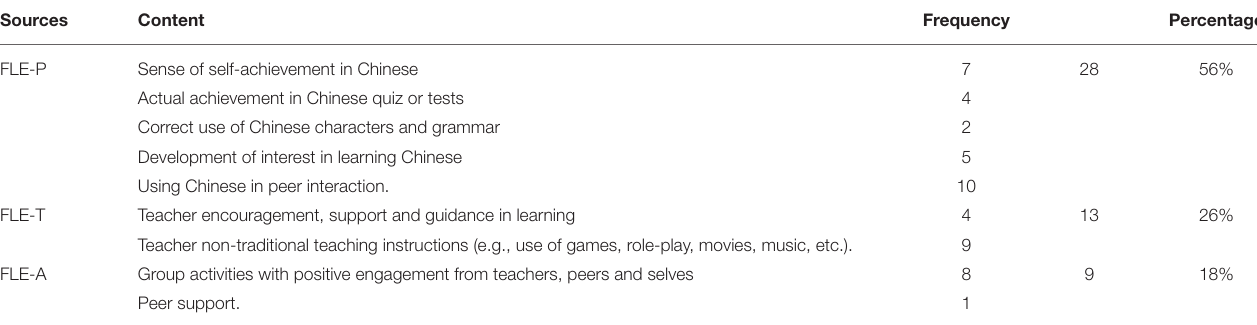
TABLE 10 | Sources of FLE in three dimensions mentioned by 20 participants. Sources Content Frequency